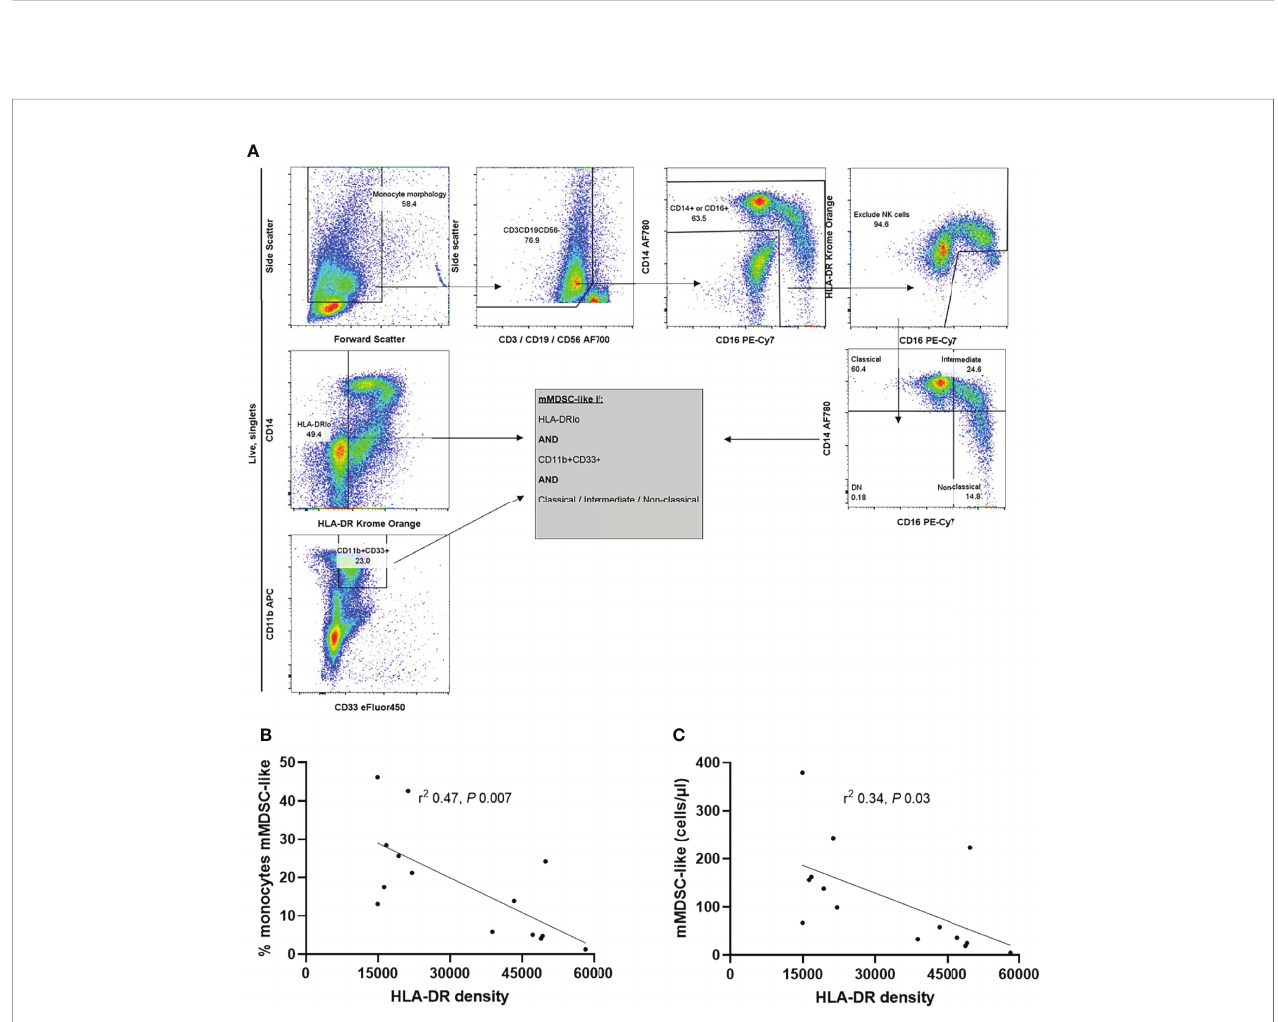
FIGURE 4 | mHLA-DRd correlates inversely with CD19 - CD3 - CD56 - CD14 +/int CD11b + CD33 + HLA-DR lo monocyte myeloid-derived suppressor-like cell accumulation. (A) Example of gating strategy to delineate monocyte subpopulations. The plots on the far left were derived from live (7AAD-negative), singlet cells. MDS like-cells were derived from a Boolean gate, and were HLA-DRlo, CD11b+CD33+ and of classical, non-classical or intermediate monocyte morphology. Correlation between mHLA-DRd and (B) proportion of mMDSC-like cells within the monocyte population and (C) absolute number of mMDSC-like cells. Spearman ’ s test was used to assess goodness-of- fi t (r 2 ) and signi fi cance.